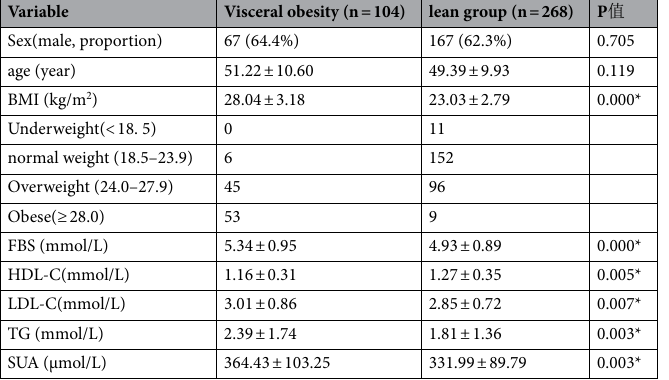
Table 1. Personal and laboratory results in visceral obesity and lean group. FBS fasting blood sugar, HDL-C high density lipoprotein, LDL Low-density lipoprotein, TG triglycerides, SUA serum uric acid. *P < 0.05.